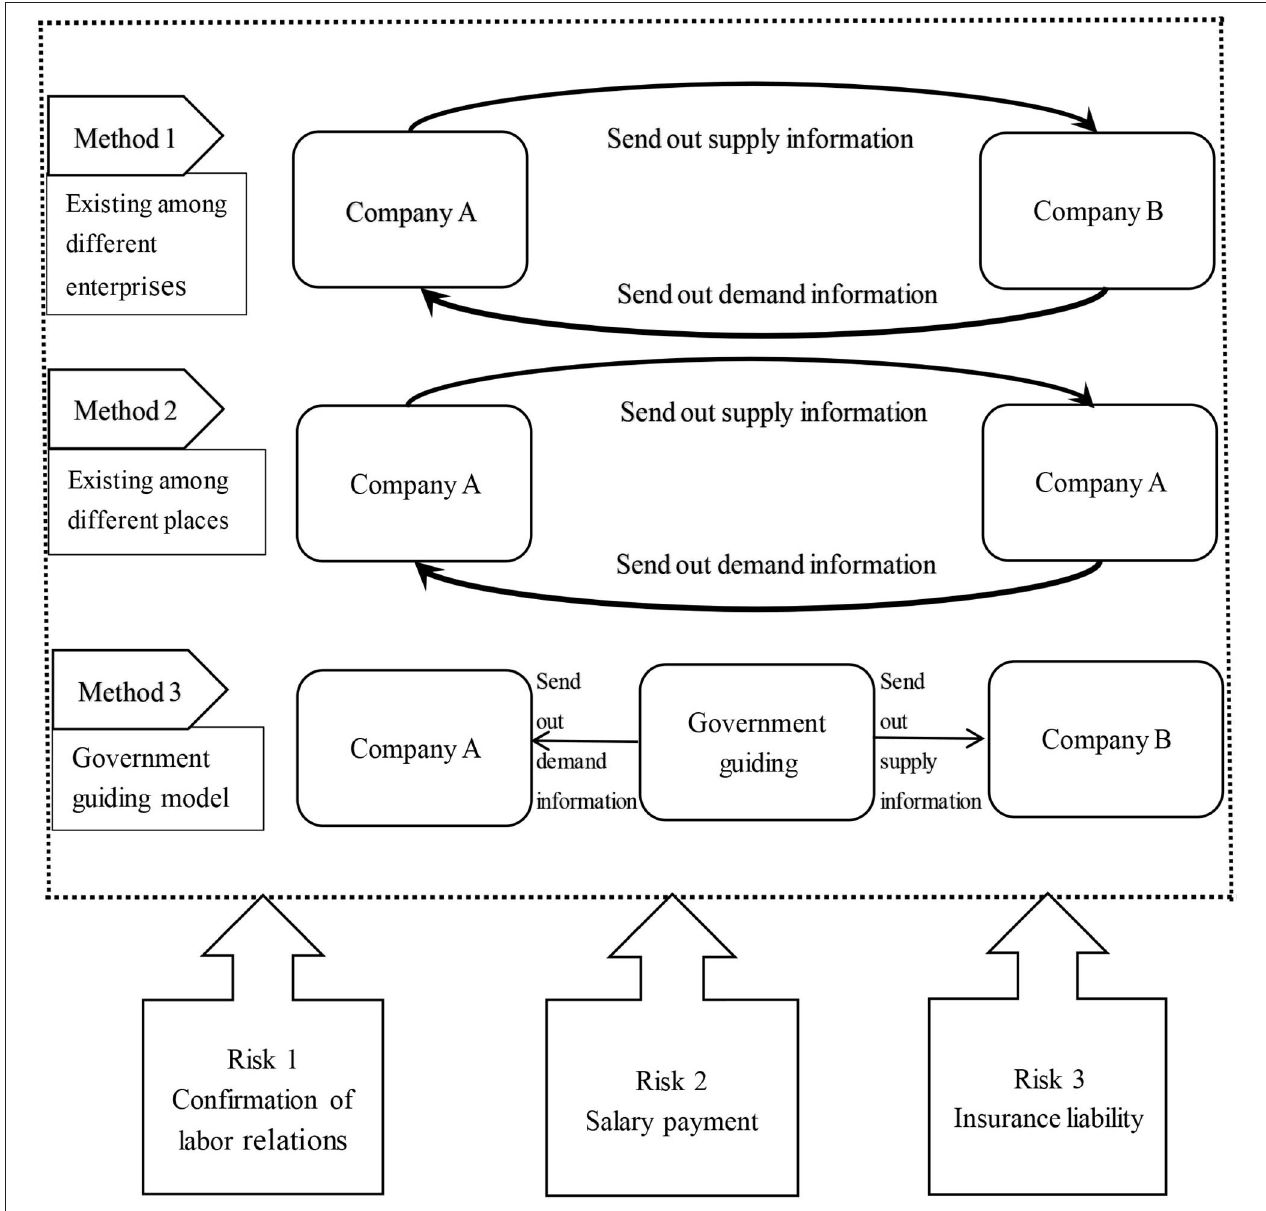
FIGURE 1 | “Sharing employees” model, method, and